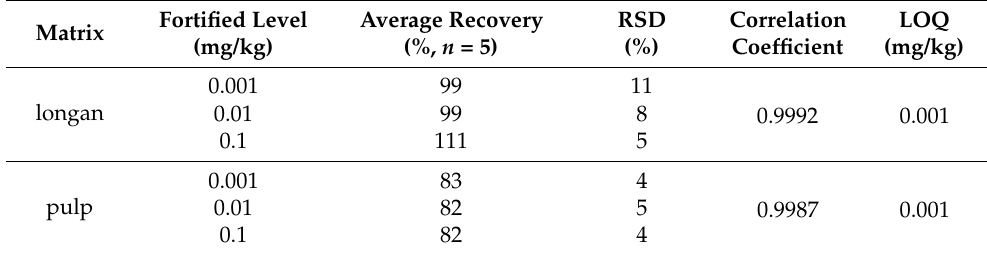
Table 1. Performance characteristics of the method for emamectin benzoate in the whole longan and